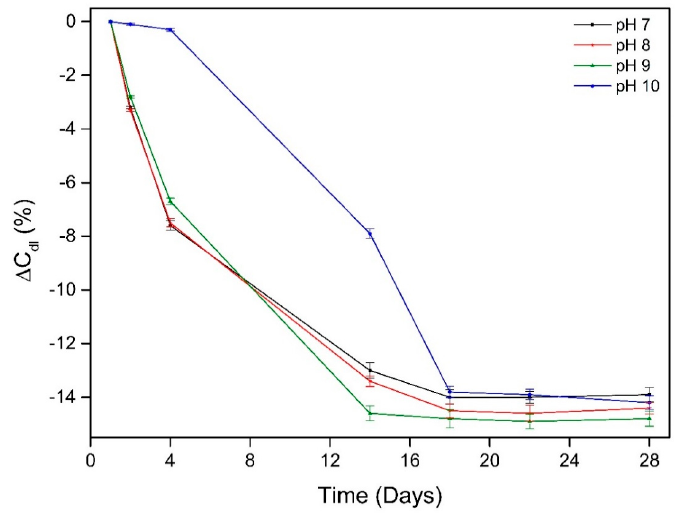
Figure 8. Change in double layer capacitance during exposure time of working electrodes in different pH environments.